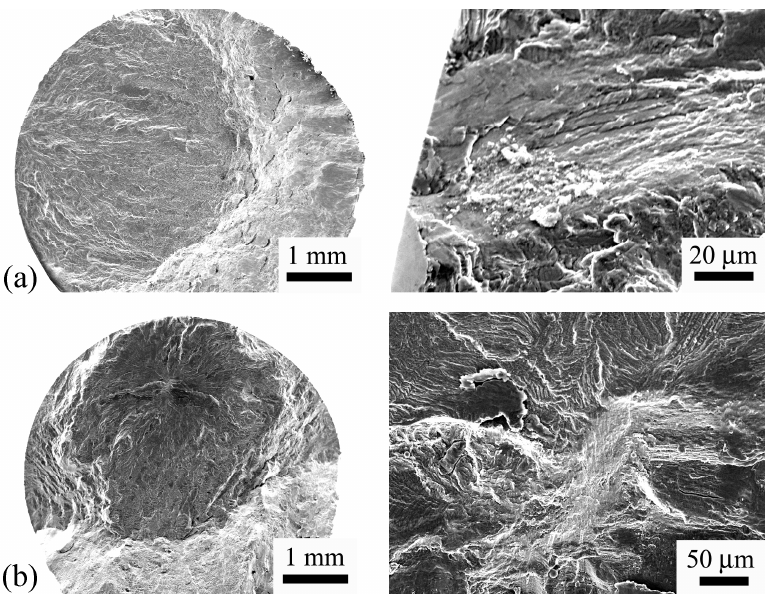
Figure 6. SEM observations of fracture surfaces for HC specimens. ( a ) Crack initiates from specimen surface, σ a = 693 MPa, N f = 3.27 × 10 5 ; ( b ) Crack initiates from the interior of specimen, σ a = 630 MPa, N f = 2.52 × 10 6 .